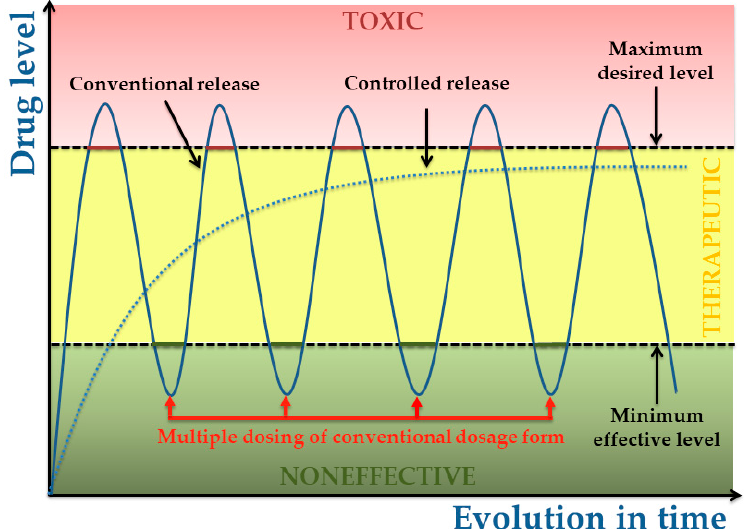
Figure 3. Plasma drug concentration profiles for conventional and controlled release formulations